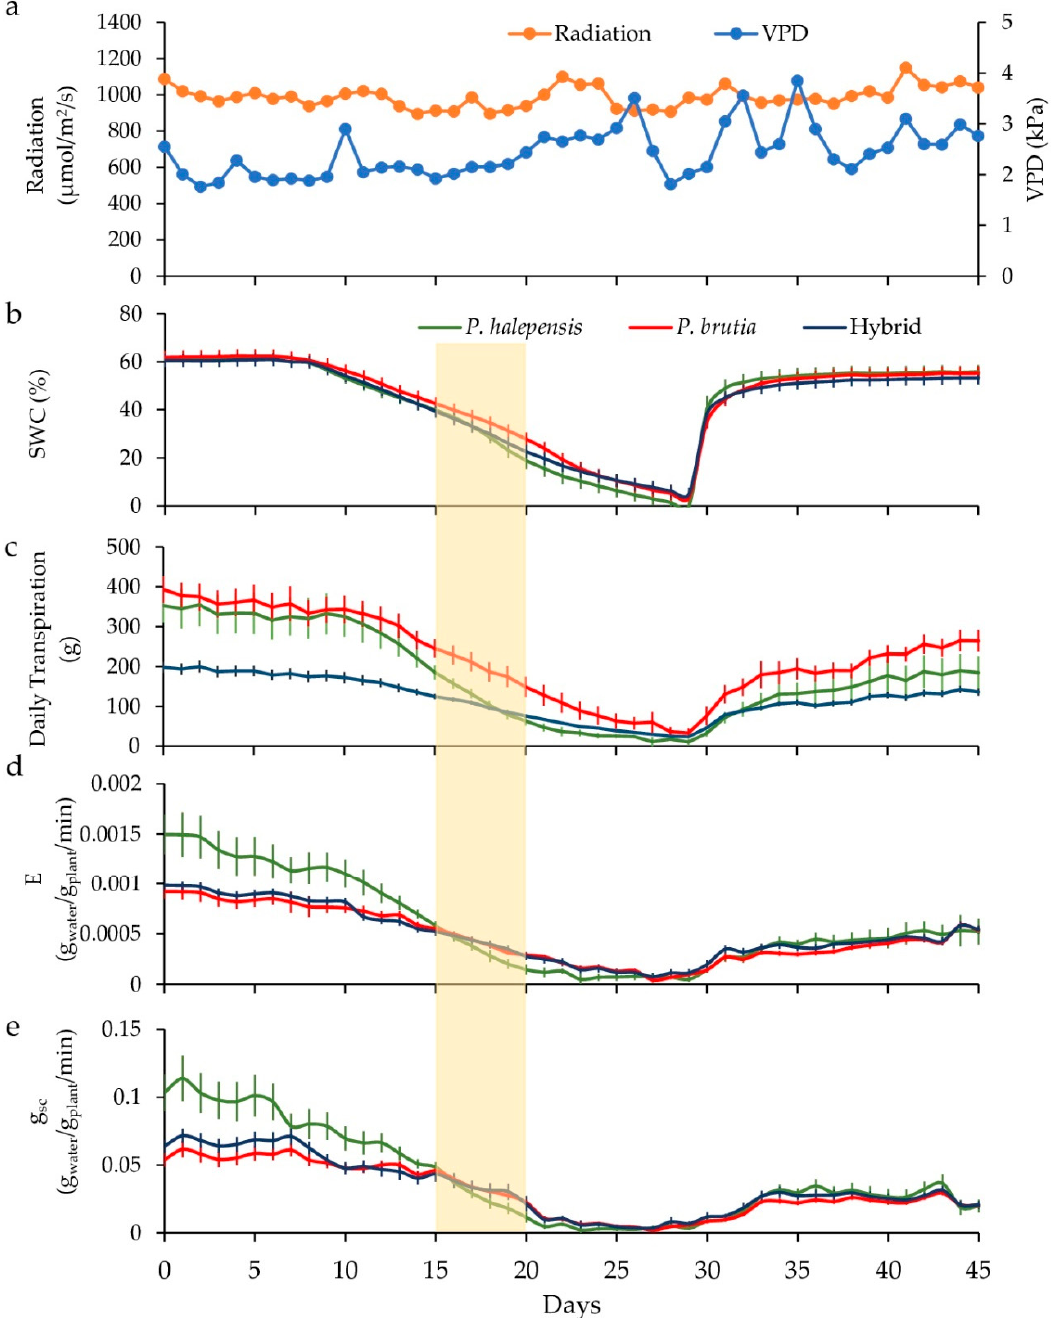
Figure 1. Environmental conditions during the drought experiment and the responses of P. halepensis (green), P. brutia (red), and their hybrids (blue) to drought stress during the 45 days of the experiment. ( a ) Maximum daily solar radiation and VPD, ( b ) soil water content (SWC), ( c ) daily transpiration, ( d ) midday whole-plant transpiration rate (E), ( e ) midday whole canopy stomatal conductance (g sc ). The yellow column marks the start of the reduction in the leaf water potential ( Ψ PD ) (Figure 2).